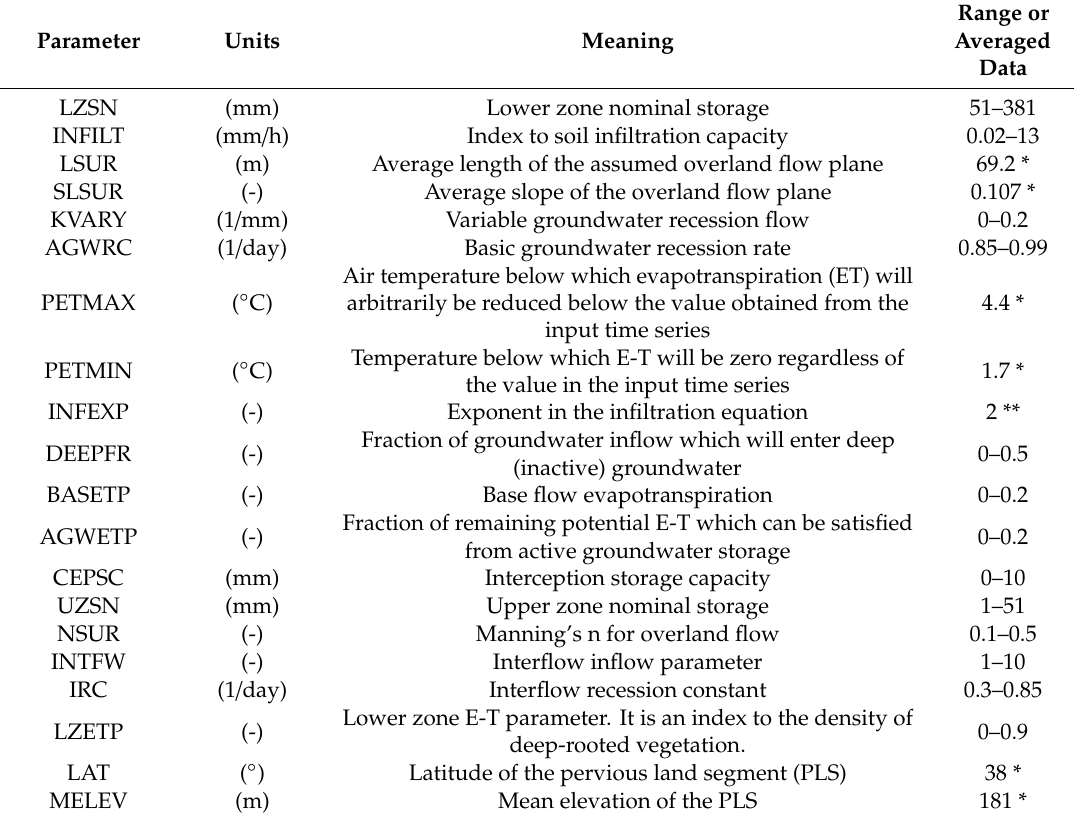
Table 4. Parameters required to build up a Hydrologic Simulation Program in Fortran (HSPF)